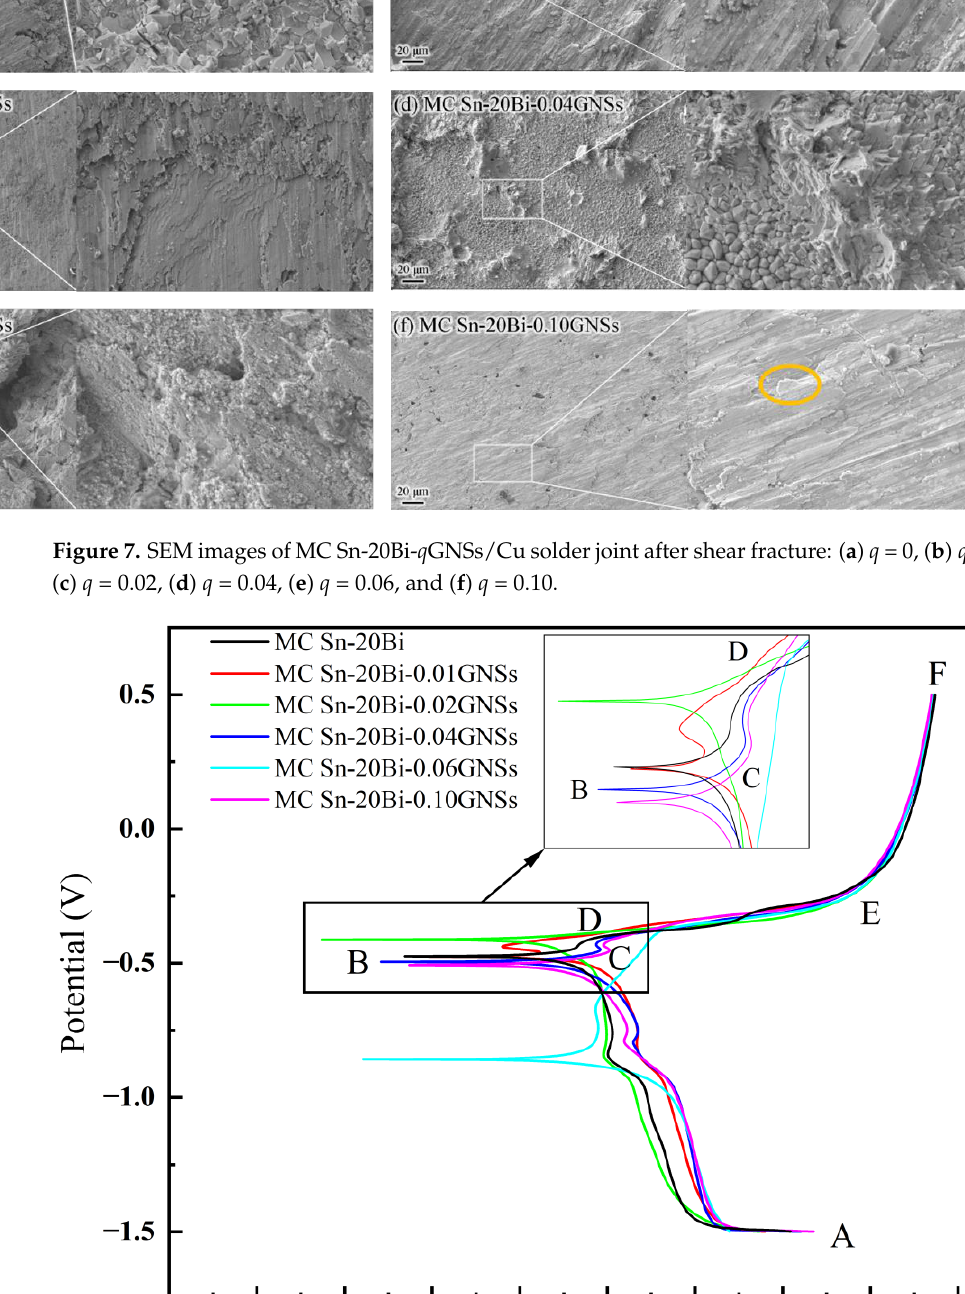
Table 2. Electrochemical corrosion parameters of MC Sn-20Bi- q GNSs alloys in 3.5 wt.% NaCl solu- tion.